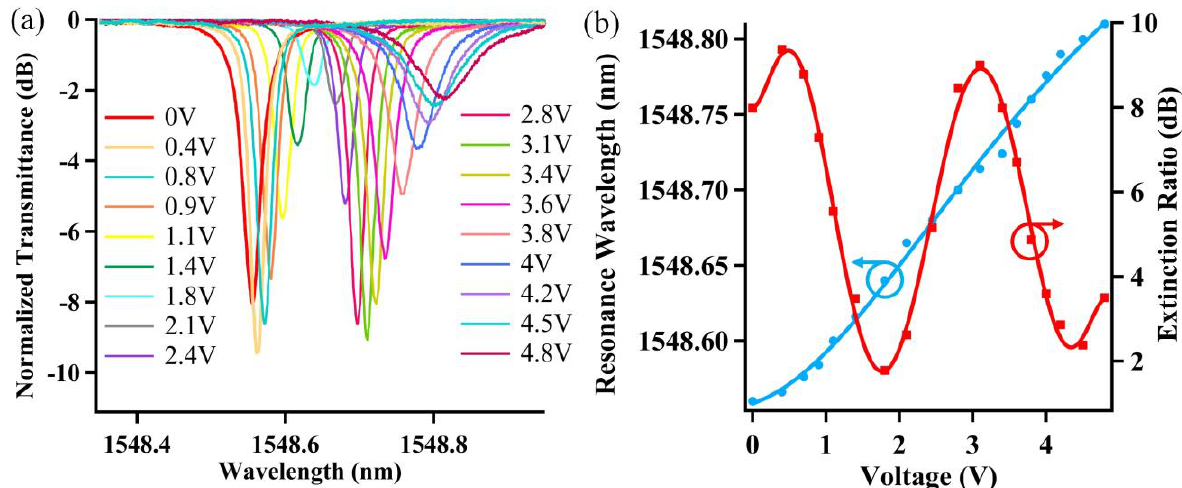
Figure 6. ( a ) Response spectra with changing voltage imposed on the microheater above U-shaped path. ( b ) The corresponding resonance wavelength and extinction ratio variation with the imposed voltage.